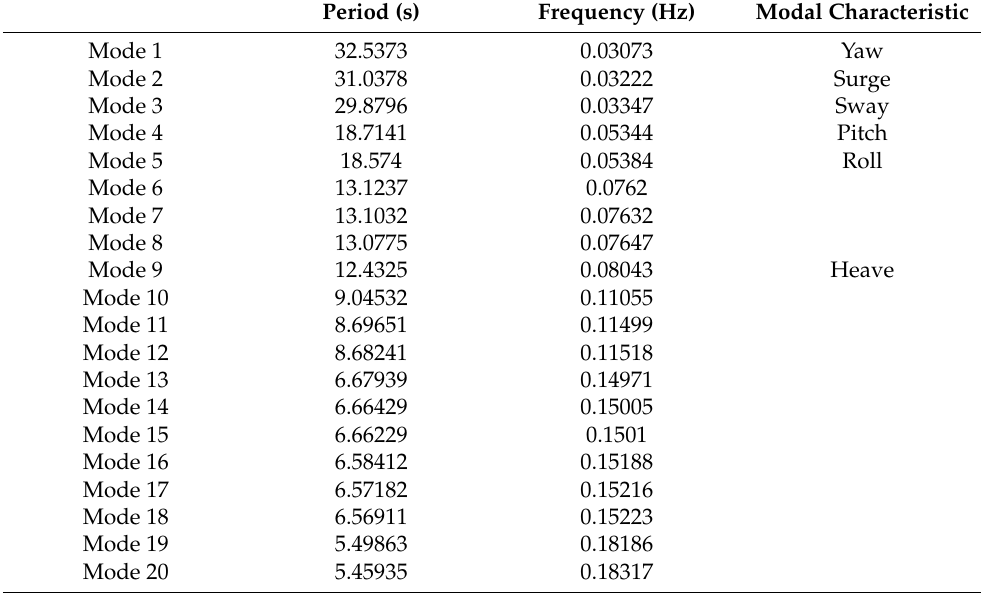
Table 9. The first 20 modes of the new wind